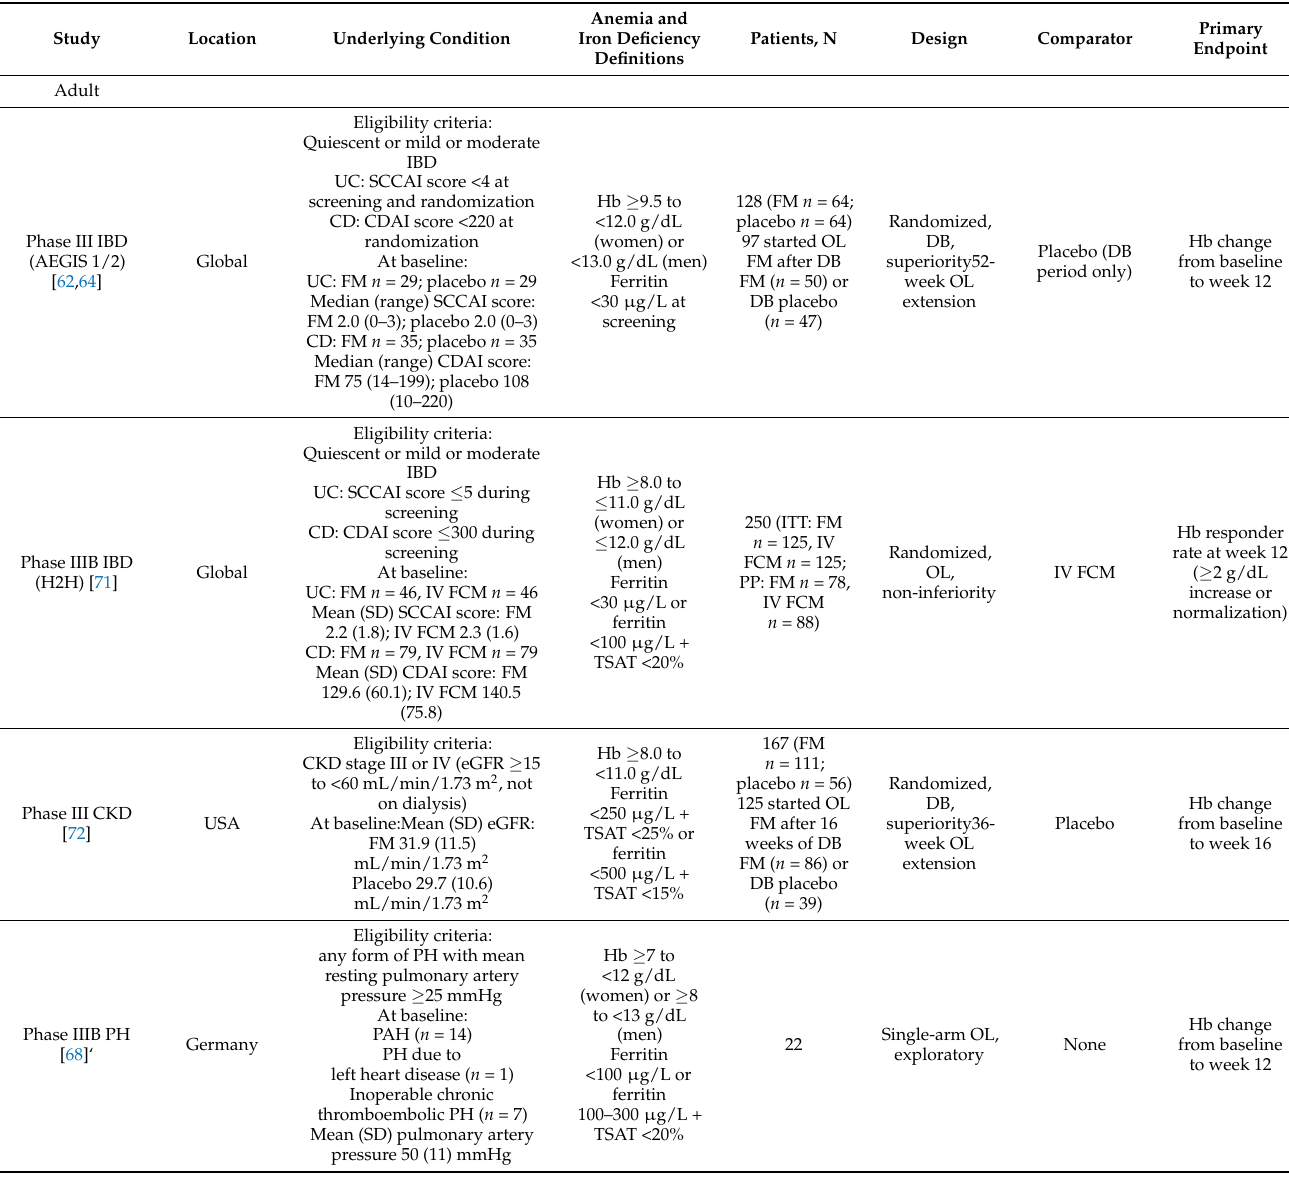
Table 1. Designs of key ferric maltol clinical